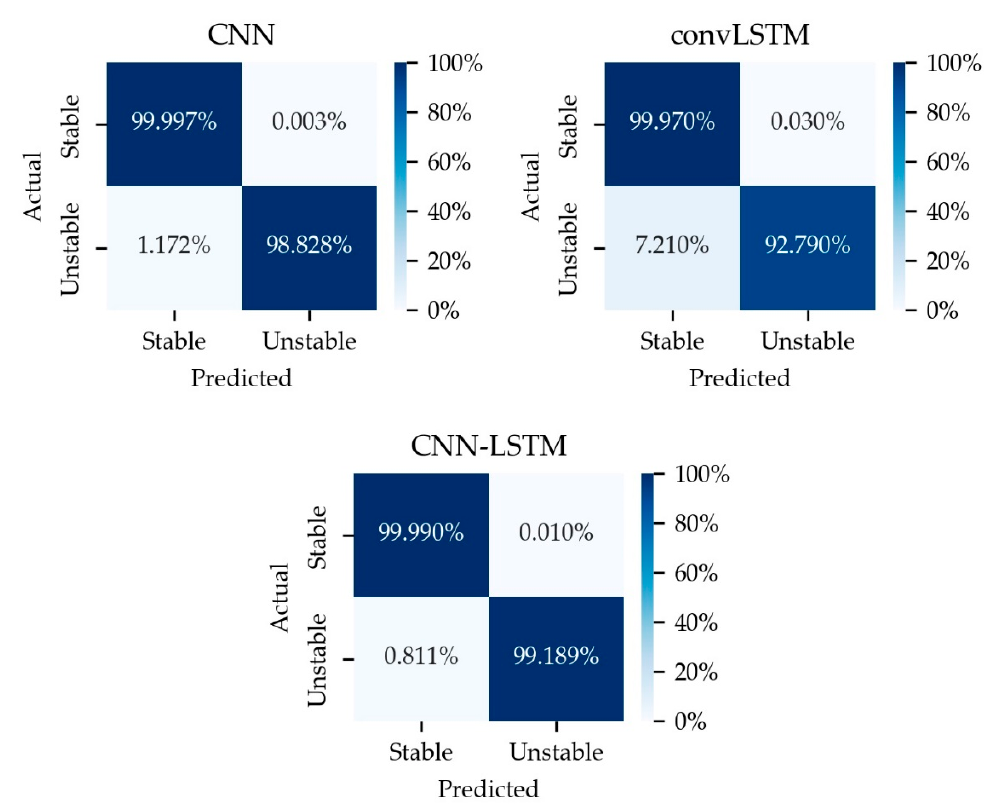
Figure 13. Recapitulation of normalized confusion matrix for comparing deep learning methods. Table 11. Computational time for comparing deep learning methods.